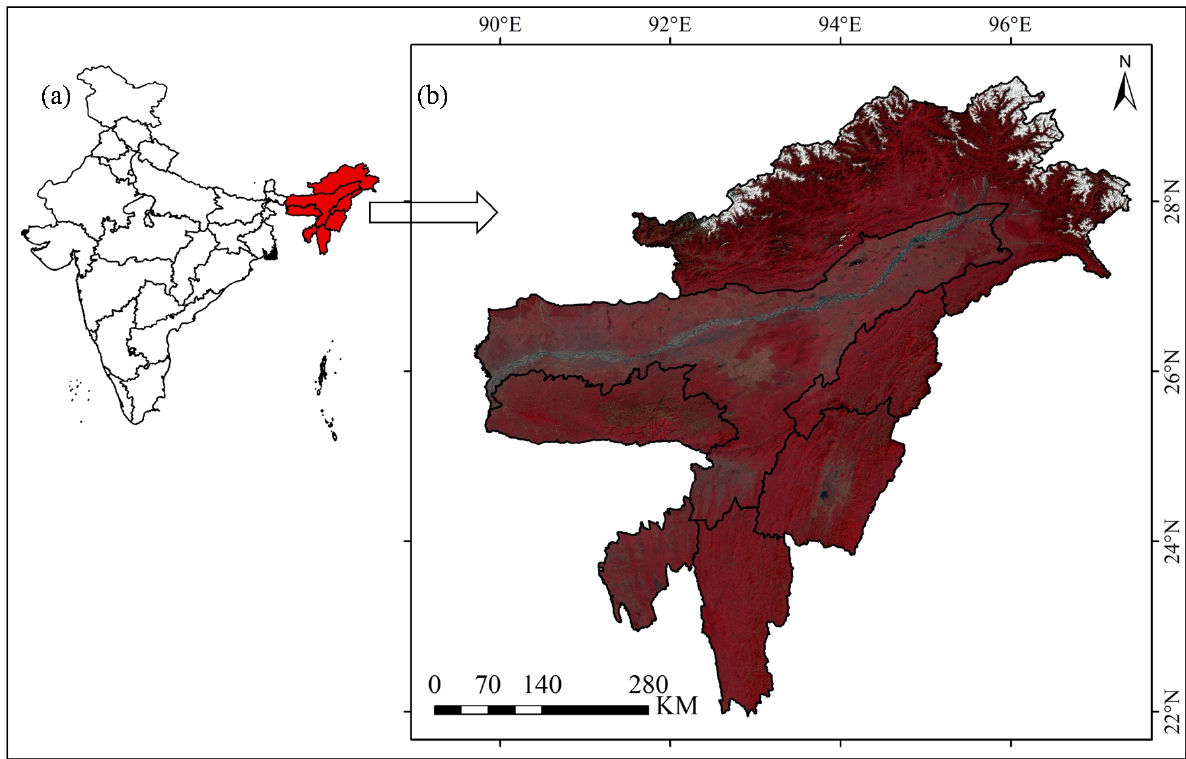
Figure 1. ( a ) Location map of seven sister states (shaded with light red color) of Northeastern India ( b ) A standard false color composite, SFCC generated by mosaicking many Landsat images (year: 2018)